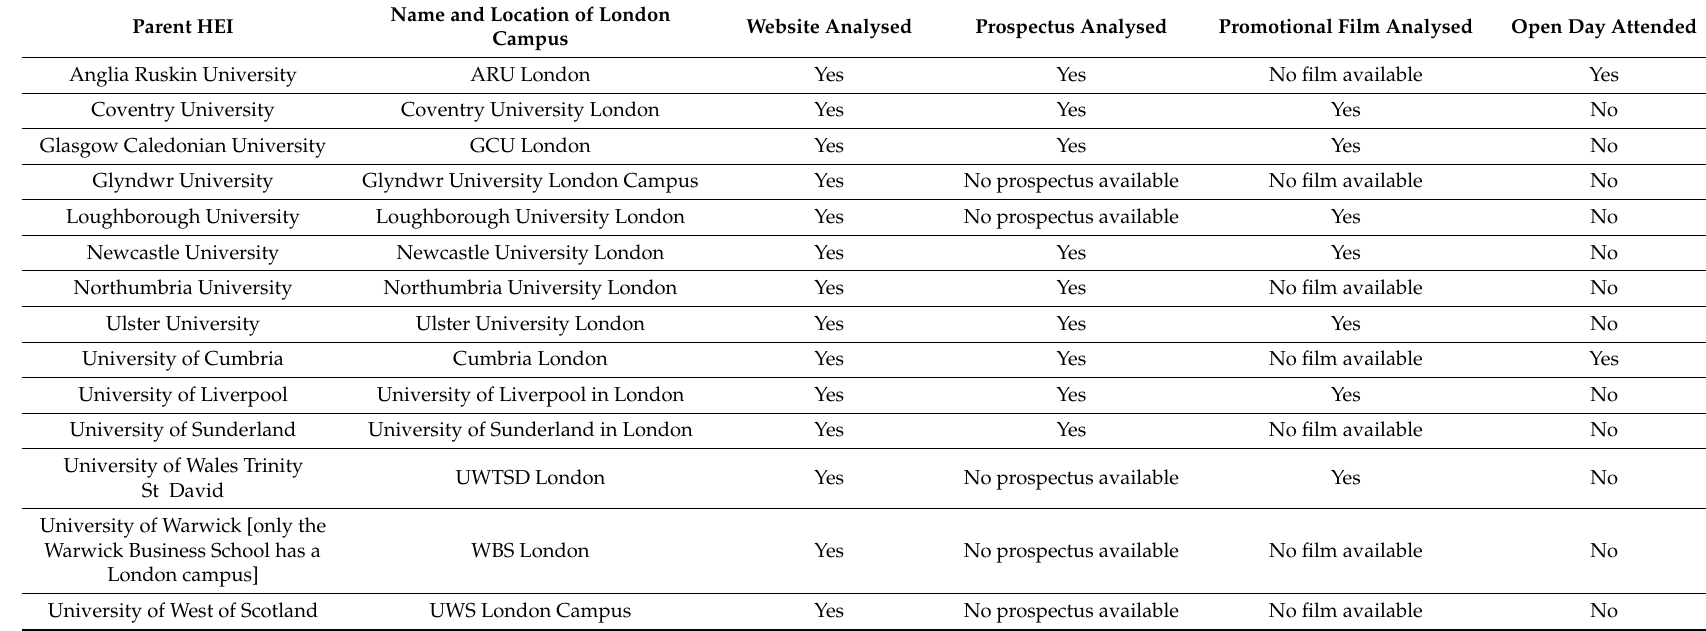
Table 1. London campuses and methods of data